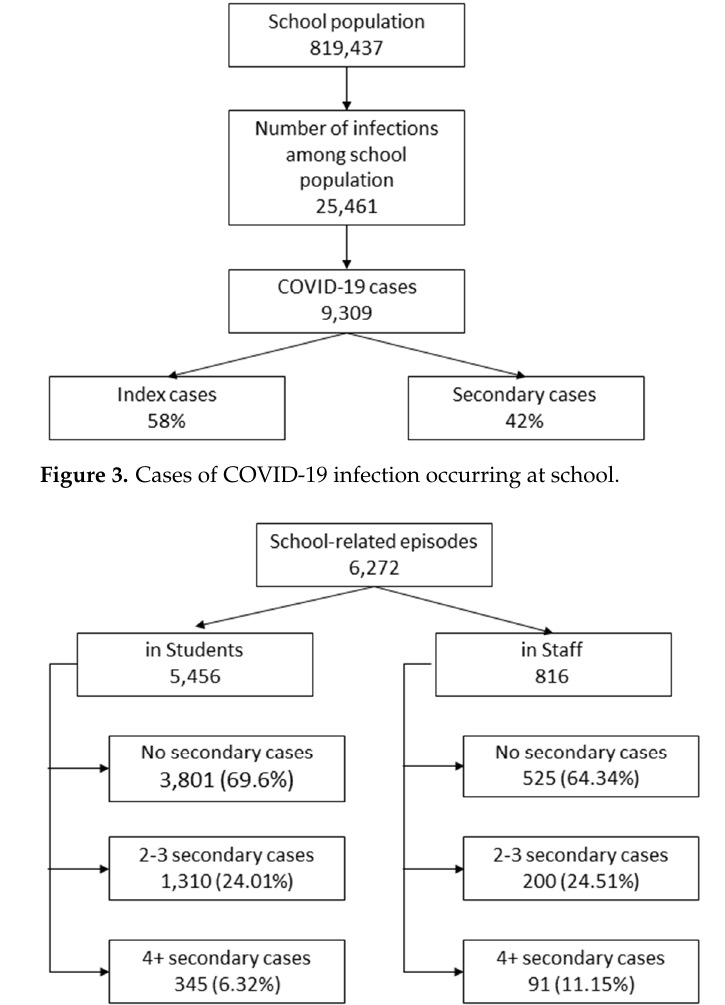
Figure 4. School-related episodes of infection, in students and staff.